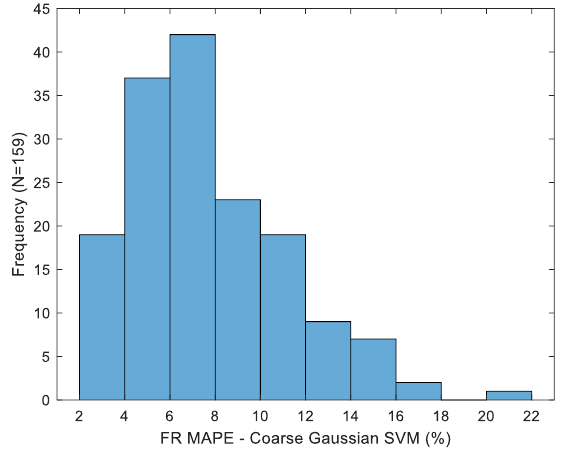
Figure 11. Distribution of the fill ratio mean absolute percentage error across trials for the best-case estimator.